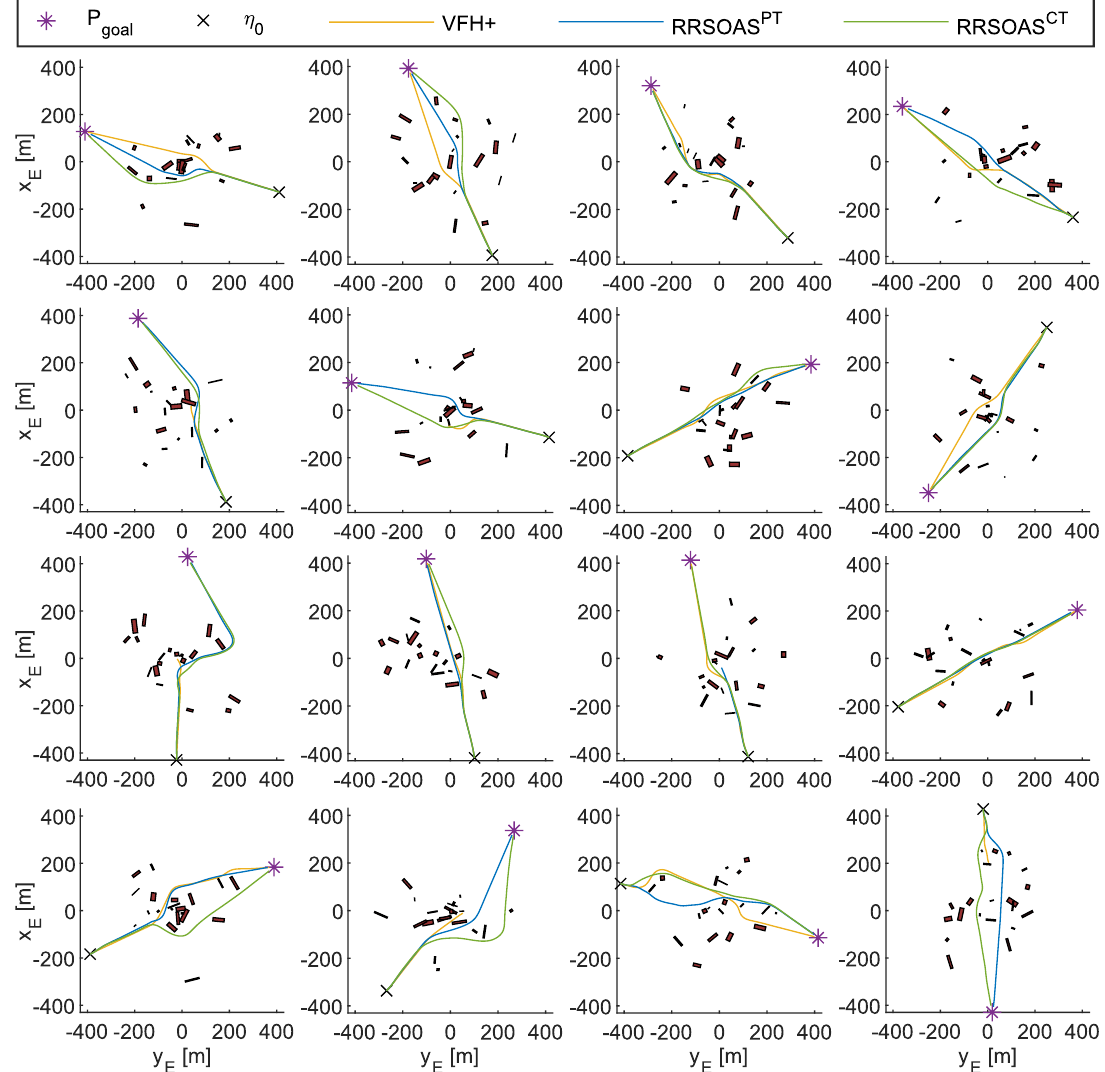
Figure 14. Paths of the vessel (1), in sixteen of the nine-hundred scenarios studied in this work, when it is guided autonomously by the algorithms RRSOAS and VFH+